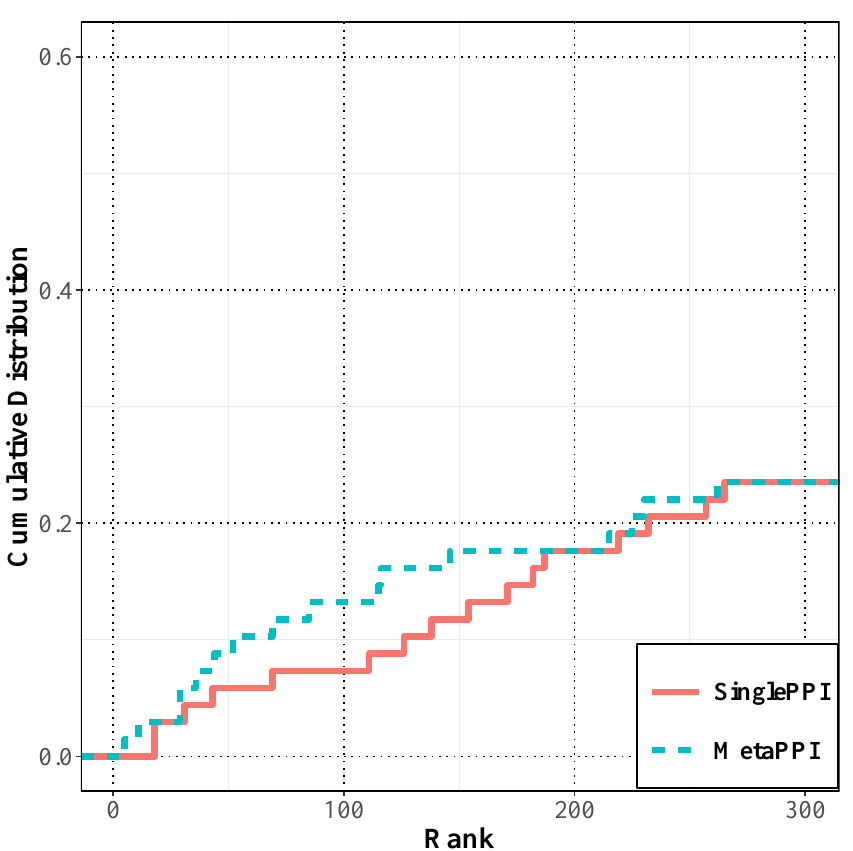
Figure 2. The prediction performance of the RWR algorithm on the PPI network. The cumulative distribution functions represent the ranks of the left-out genes in the LOOCV with different network construction. (The X-axis is the rank of the nodes in the network, and the Y-axis is the ratio of the number of left-out genes ranked at the top to the number of genes in the test